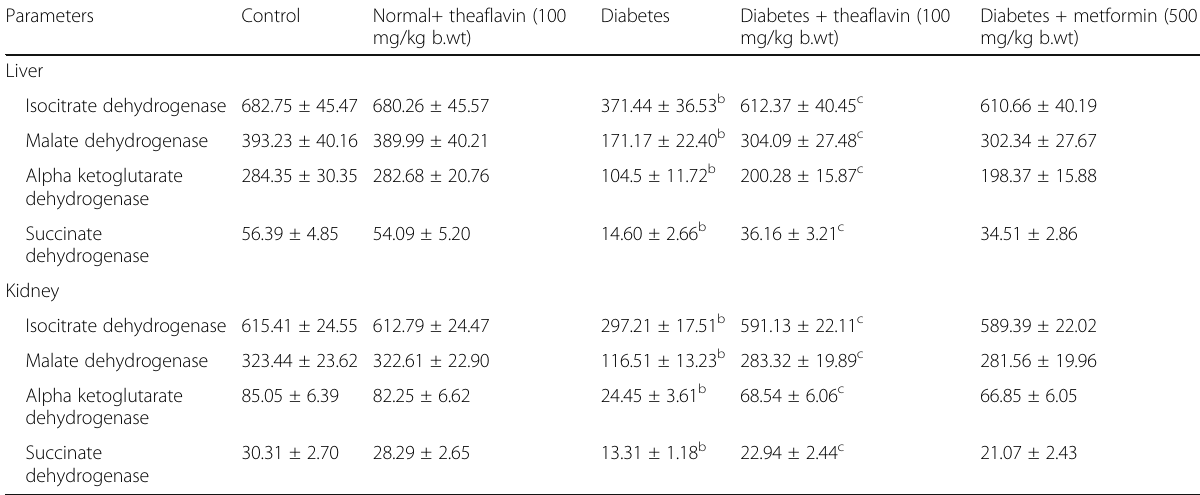
Table 4 Effects of theaflavin on TCA cycle enzymes in control and experimental animals